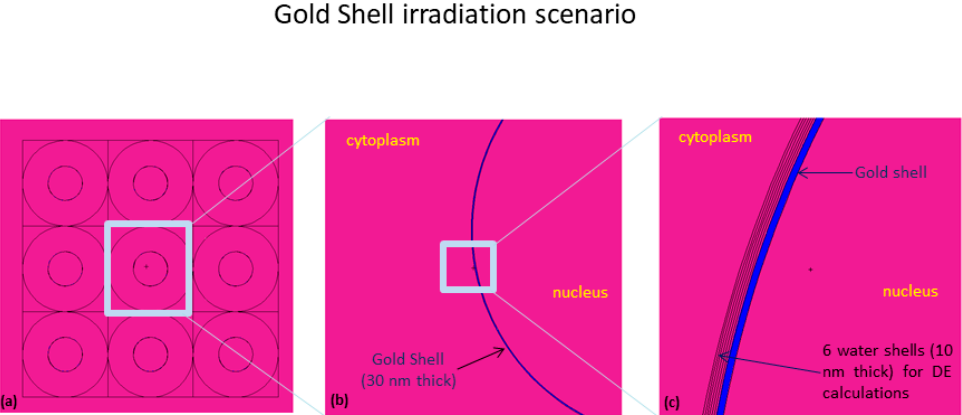
Figure 10. Geometry setup used in the case that the gold shell is around the nucleus, and radionuclide emitting homogeneously in the cytoplasm. ( a ) Entire cell irradiation setup when the emitting source is in the cytoplasm; ( b ) zoom on the gold shell of 30 nm thick around the nucleus; ( c ) zoom near the gold shell to show the nanometric shells used to calculate the dose enhancement (DE) factor.